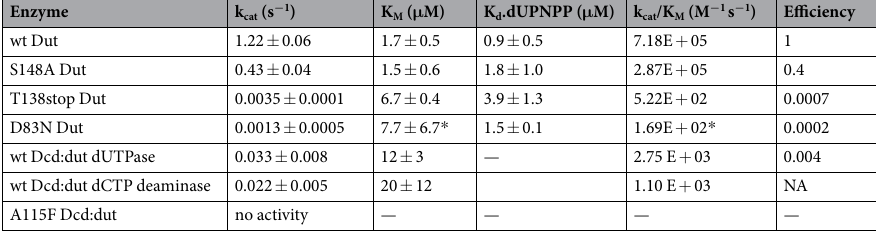
Table 1. Kinetic parameters of the M. tuberculosis Dut and Dcd:dut enzymes. * Data not reliable due to the limitations of the activity measurement. NA: not